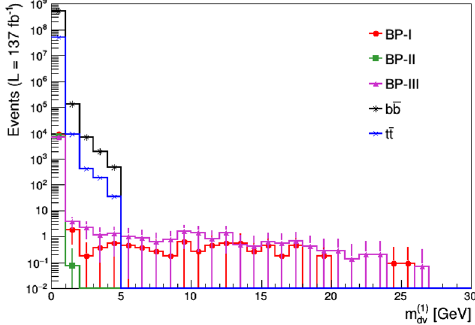
Figure 5 . Leading DV